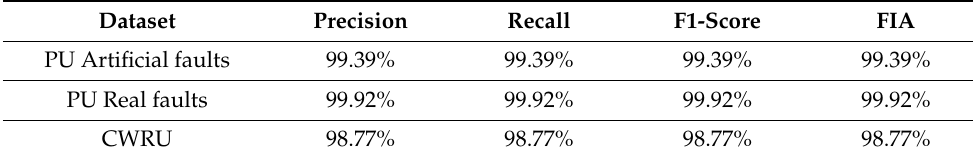
Figure 13. Confusion matrix for fault classification: ( a ) PU dataset with artificial damages; ( b ) PU dataset with real damages; ( c ) CWRU dataset. Table 6. Performance metrics for each